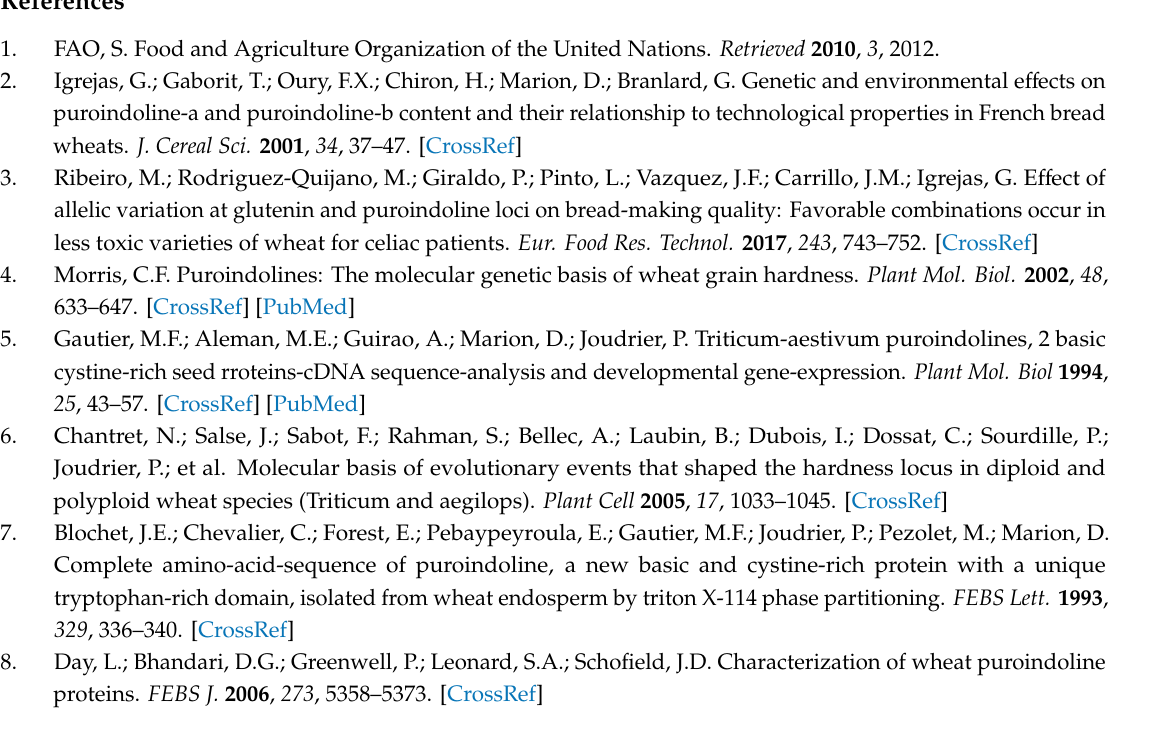
Table S1: Means for kernel hardness, weight, moisture and diameter of modern wheat. Table S2: Means for kernel hardness, weight, moisture and diameter of Polish landraces. Table S3: Means for protein, starch, and wet gluten contents of Polish landraces. Figure S1: Chromatogram fragments of five alleles found in tested wheat genotypes. Author Contributions: Conceptualization, A.N.-O. and M.P.; methodology, M.P. and S.G.; formal analysis,